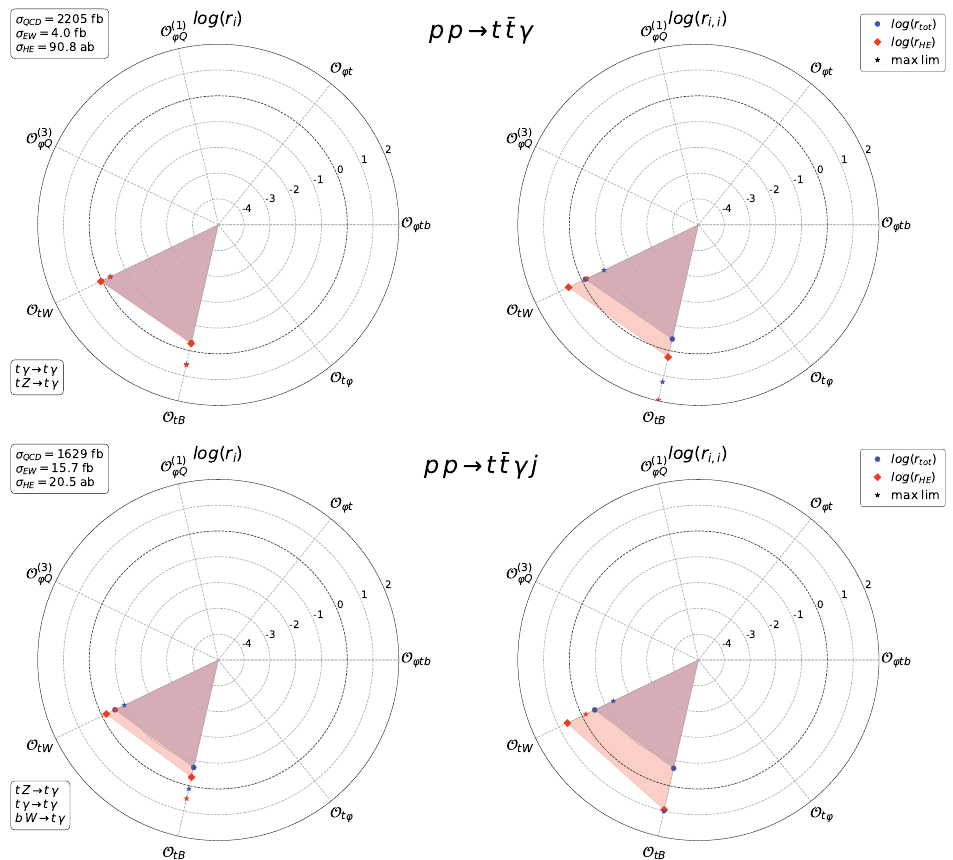
Figure 26. Radar plot for the p p LHC, see (cid:12)gure 7 and section 4.1.2 of the main text for a detailed description. The b (cid:22) b -initiated component has not been